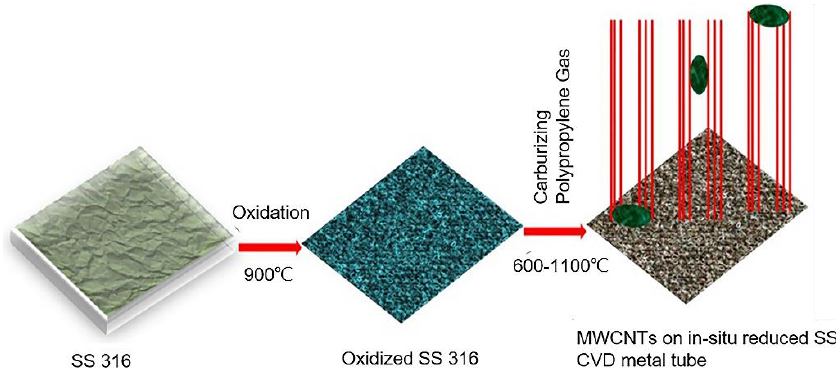
Figure 17. Mechanism of multi-walled carbon nanotube (MWCNT) growth using plastic waste and a stainless steel 316 (SS 316) metal tube [156].